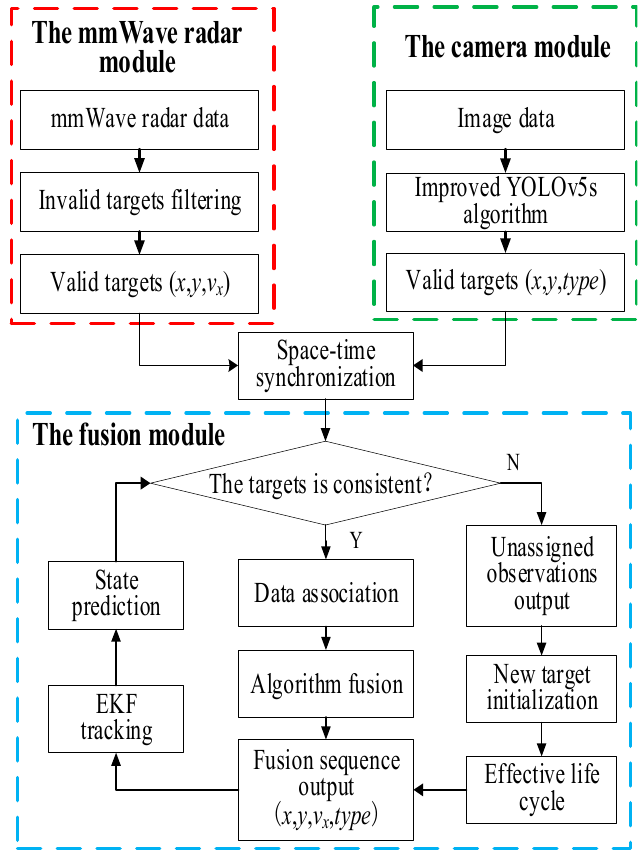
Figure 6. Framework of mmWave radar and camera information fusion.